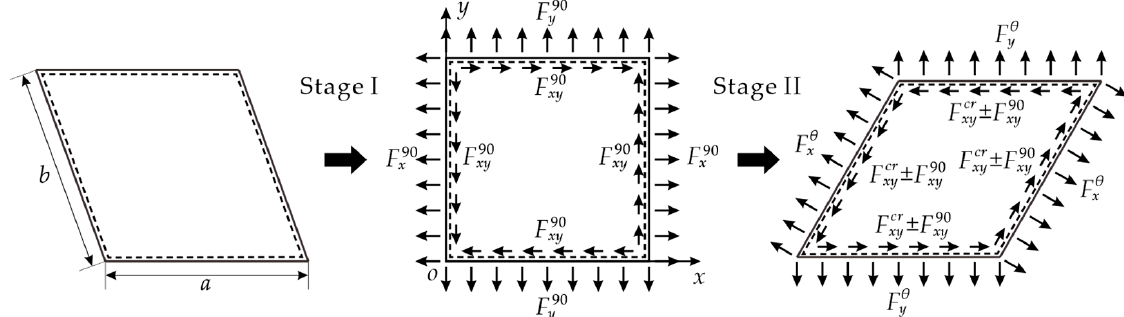
Figure 11. Deformation process of the skin.